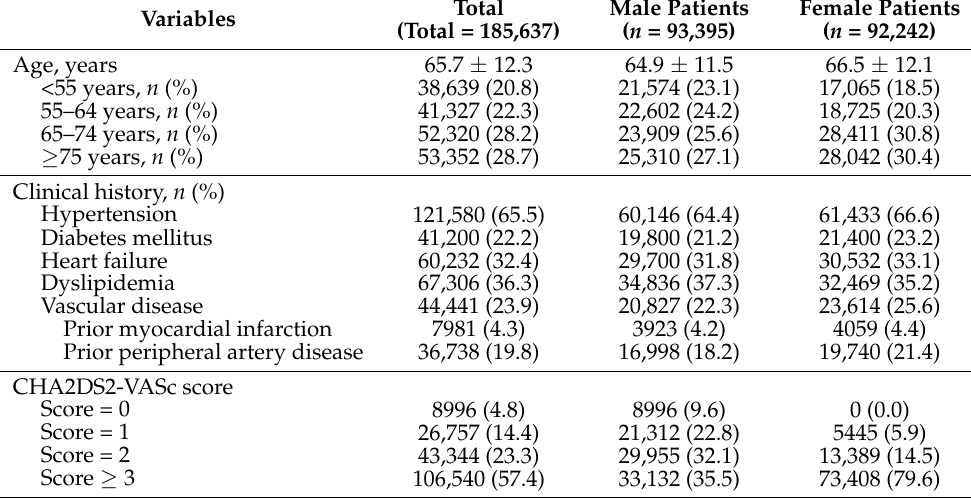
Table 2. Baseline